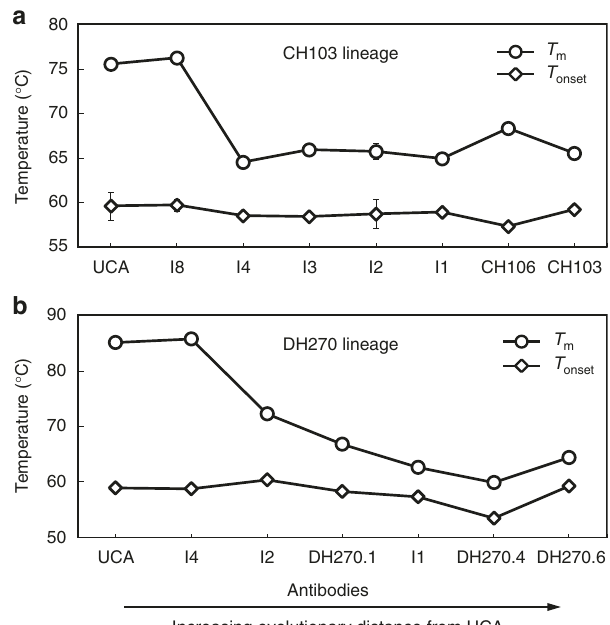
Fig. 3 Thermostability in the CH103 and DH270 bnAb lineages. a DSC thermal denaturation analysis of the CH103 lineage mAbs reveals a marked decrease in Fab domain thermostability (T m ) at the I8 to I4 transition (11.7 °C), after which, the thermal stability remains relatively constant throughout the remainder of the maturation process. The onset of whole antibody denaturation (T onset ) remains constant throughout the lineage. b DSC thermal denaturation analysis of the DH270 lineage reveals a similar marked decrease in Fab domain thermostability at the earlier I4 to I2 transition (13.4 °C), followed by an additional 8.0 °C decrease in the mature bnAb DH270.6. Data are plotted as the mean and standard deviation from a minimum of two replicate measurements. Certain error bars are smaller than the data markers at this